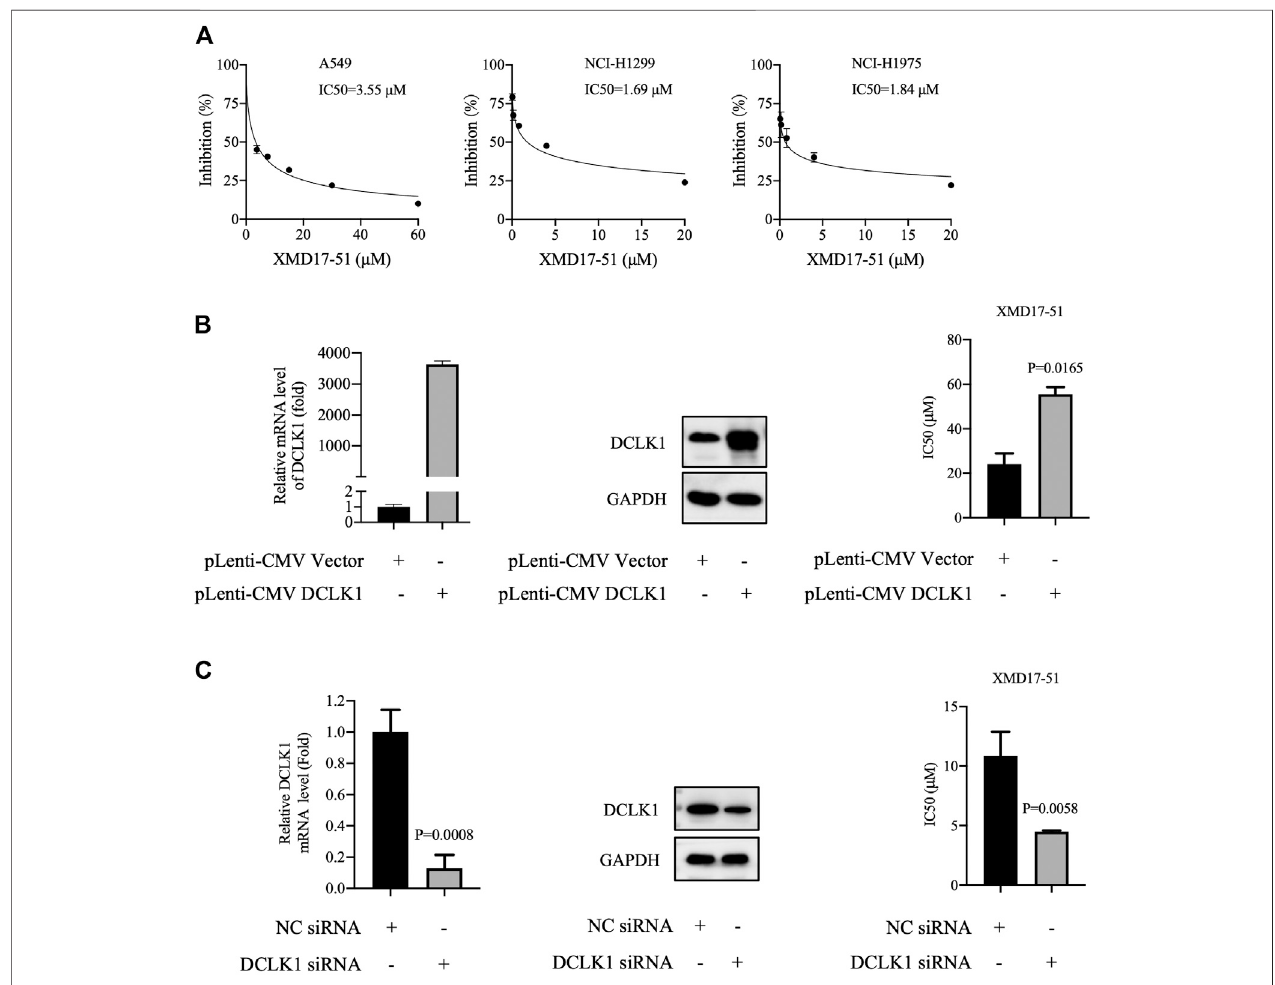
FIGURE 2 | XMD-17-51 inhibits NSCLC cell proliferation via DCLK1. (A) XMD-17-51 inhibited A549, NCI-H1299 and NCI-H1975 cell proliferation, as detected by MTTproliferationassay. (B) DCLK1overexpressionimpaired theanti-proliferativeactivity ofXMD-17-51inA549cells. (C) DCLK1-knockdown A549cellsdemonstrated a signi fi cantly decreased resistance to XMD-17-51. Data shown are representative of (graph) or are presented as the mean ± SD (blot) of at least three independent experiments. NSCLC, non-small cell lung carcinoma; DCLK1, doublecortin-like kinase 1; MTT, 3-(4,5-dimethylthiazol-2-yl)-2,5-diphenyl tetrazolium bromide.